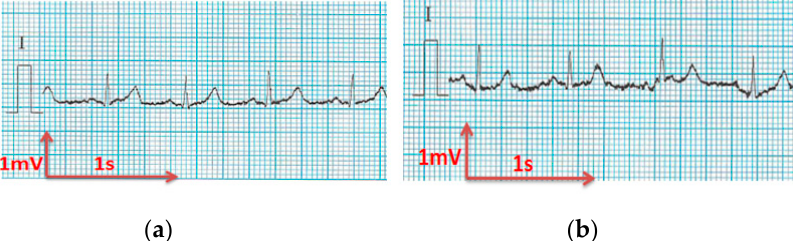
Figure 12. ECG signal obtained by cotton/Lycra electrodes with 6.3 wt.% PEDOT:PSS; ( a ) before washing; ( b ) after 50 washing cycles.